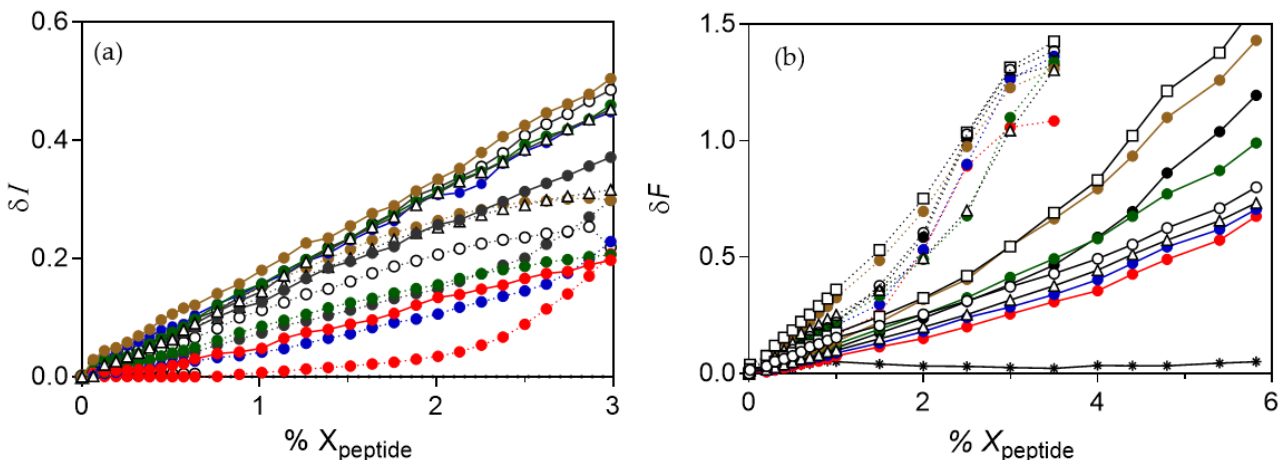
Figure 6. Effect of PxE analogues on unilamellar vesicles of different composition. ( a ) Change in light scattering. ( b ) Increase in FRET intensity as a function of the mole fraction of lipopeptide added to a (1:1) mixture of vesicles containing 0.6% NBD-PE or Rh-PE. Vesicles of POPE/POPG (6:4) (dotted line), POPG (solid line). Peptides are analogues of colistin numbered as in Table 1: spE-1 ( ● ), spE-2 ( ● ), spE-3 ( ● ), spE-4 ( ● ), spE-7 ( △ ), spE-8 ( ◻ ), spE-10 ( ◯ ), or PxE ( ● ). In all cases, no representative changes were detected with POPC vesicles, as shown in ( b ) for PxE ( ∗ ). Each data is the mean of three independent experiments, with error being always below 10%.